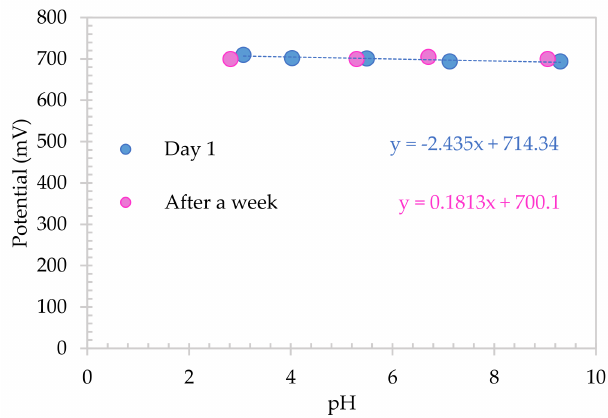
Figure 8. Calibration plot for SA electrode in diluted Hoagland solution for day 1 and after being stored in solution over a